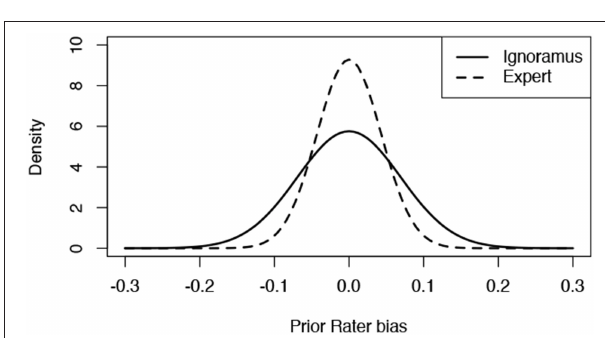
FIGURE 9 | Prior for rater biases as estimated by the model using ρ